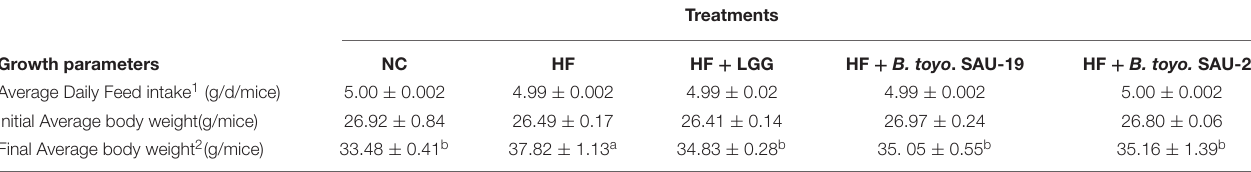
TABLE 4 | Effect of Bacillus toyonensis SAU-19 and SAU-20 on Average daily feed intake (g/d/mice) and Average weight (g/mice) of mice fed high fat